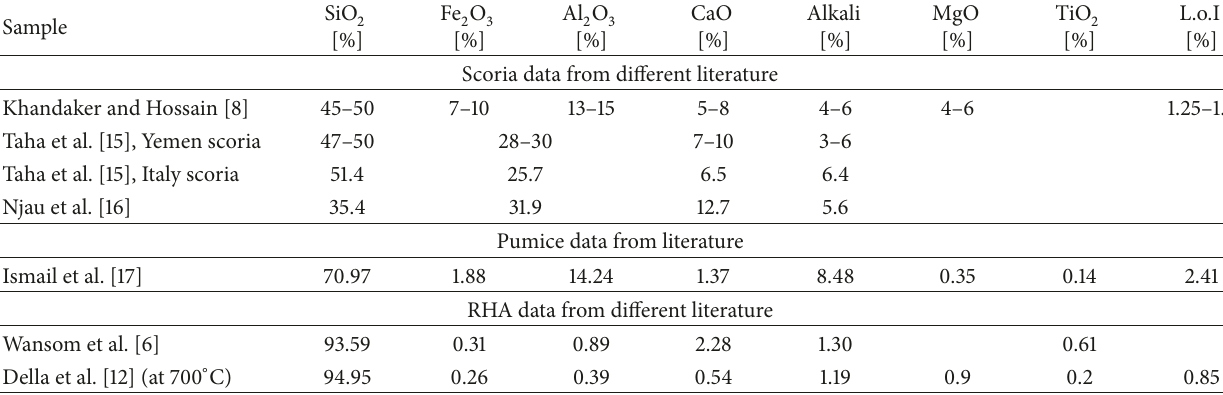
Table 1: Chemical compositions of scoria, pumice, and RHA from different literatures.